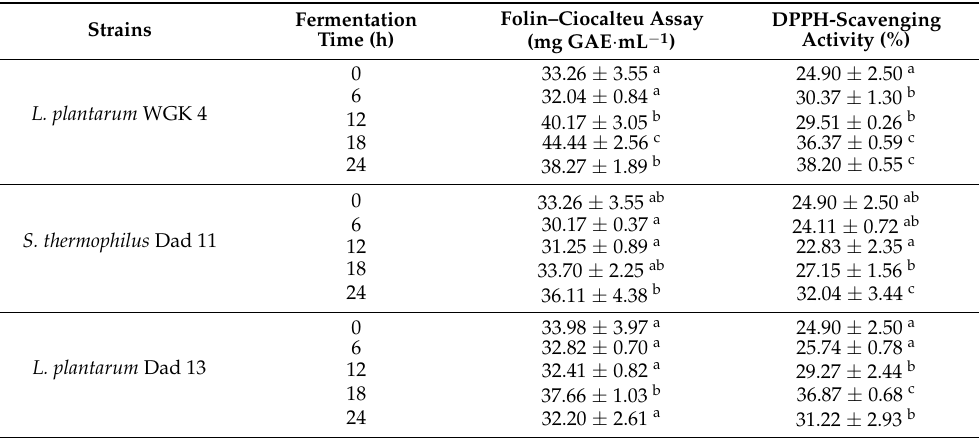
Table 6. Folin–Ciocalteu assay and DPPH-scavenging activity of black soy milk during fermentation by Indonesian indigenous LAB (24 h, 37 ◦ C).